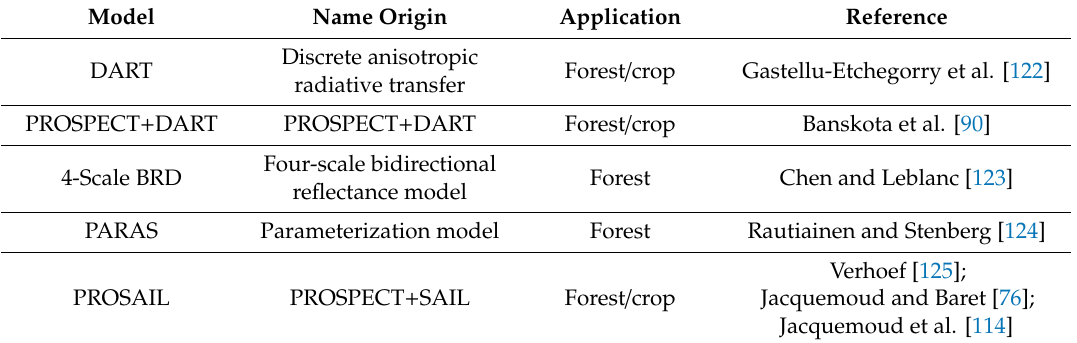
Table 4. Summary of popular physical models for characterizing